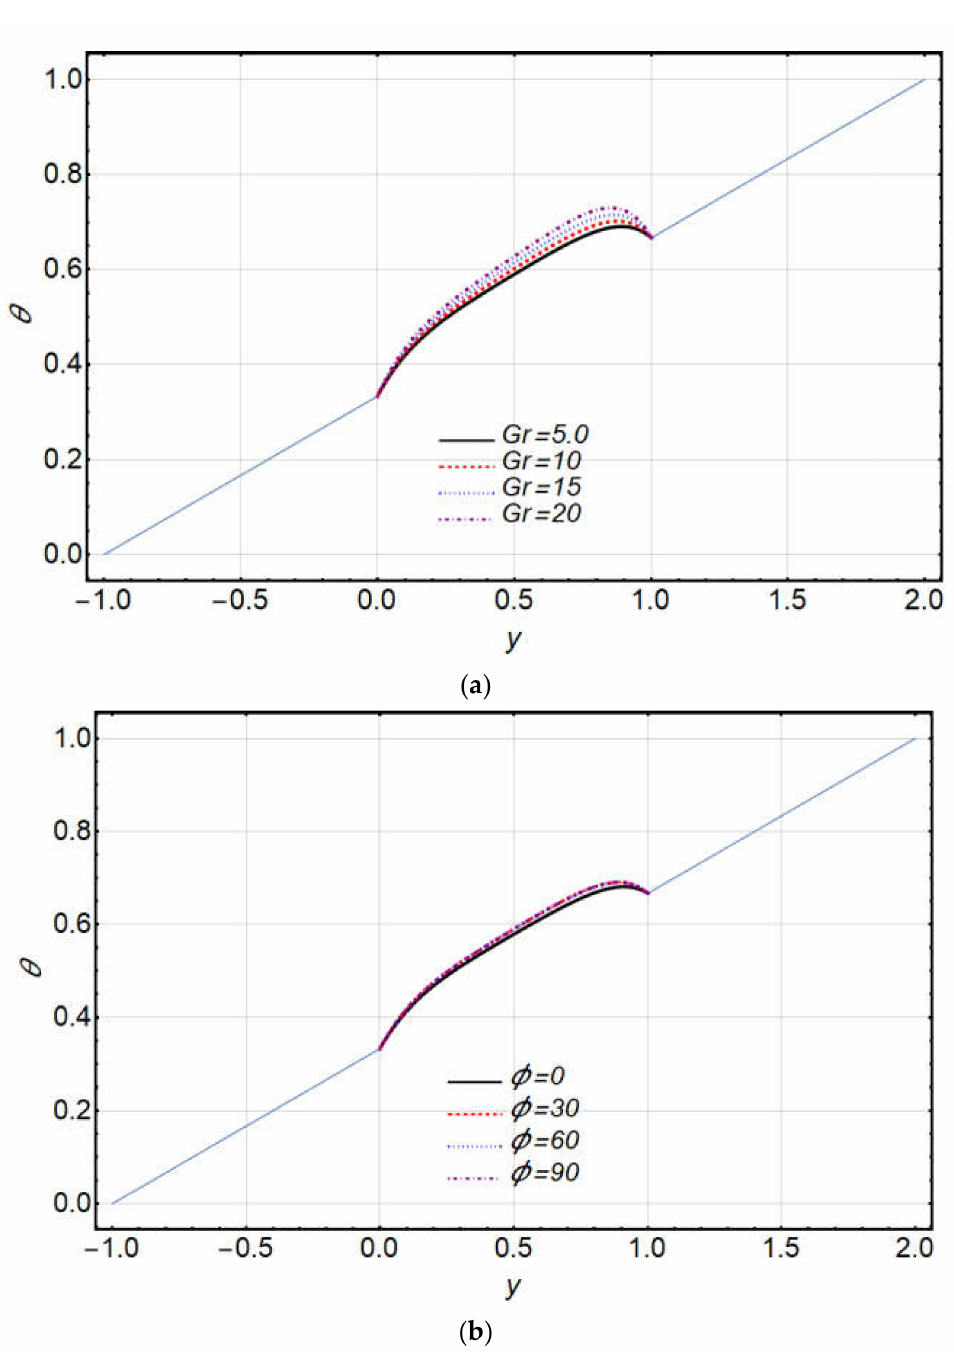
Figure 12. Temperature distribution against ( a ) Gr , ( b ) φ